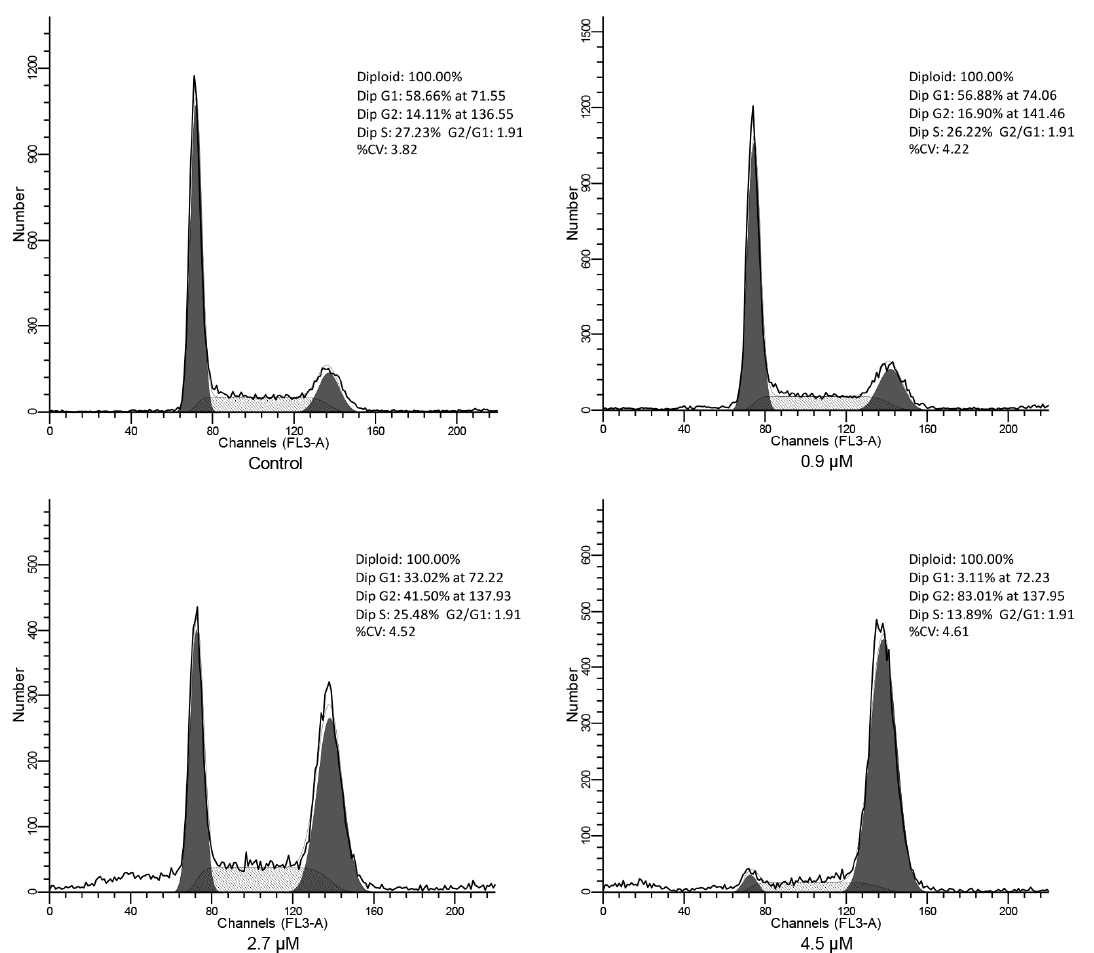
Figure 3. Effects of compound b17 on cell cycle progression in HepG-2 cells. Cells were treated with b17 at concentrations of 0 µM, 0.9 µM, 2.7 µM, and 4.5 µM for 24 h.